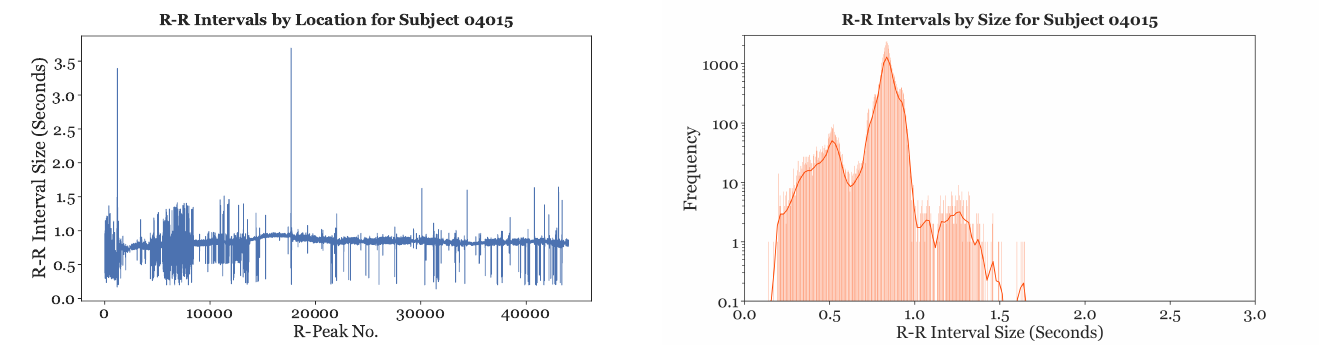
Figure 3. Sample of the line plot and histogram of R-R intervals for Subject 04015.